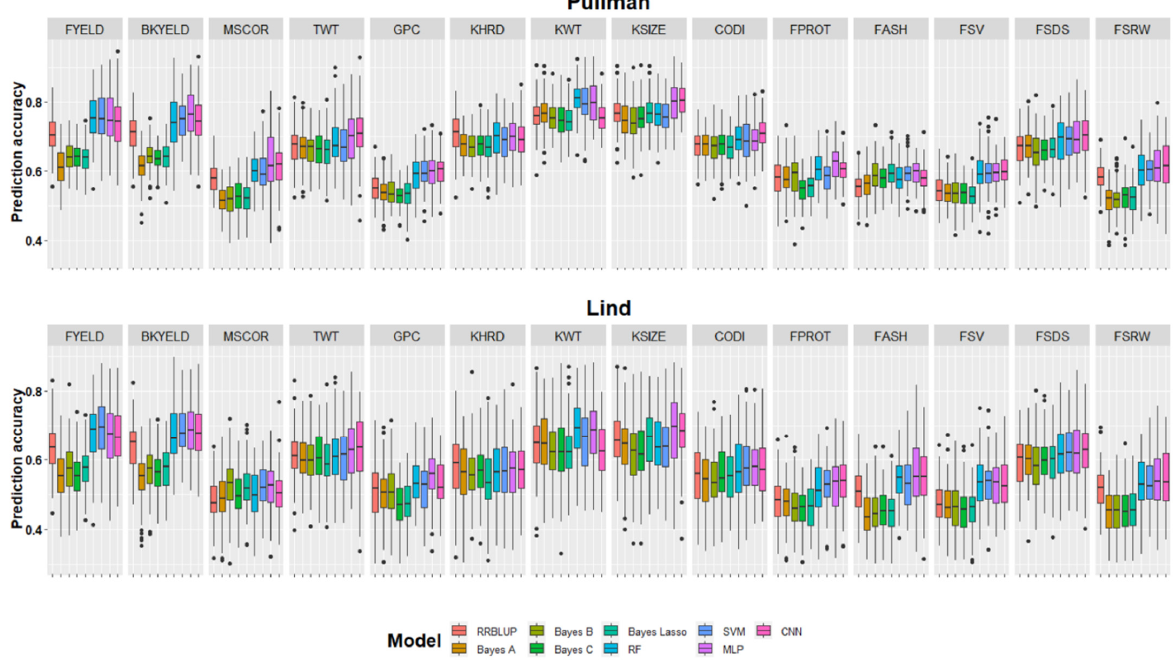
Figure 2. Genomic selection cross-validation prediction accuracies for fourteen end-use quality traits evaluated with nine different models. Results are provided separately for both locations and each trait is separated with facets.